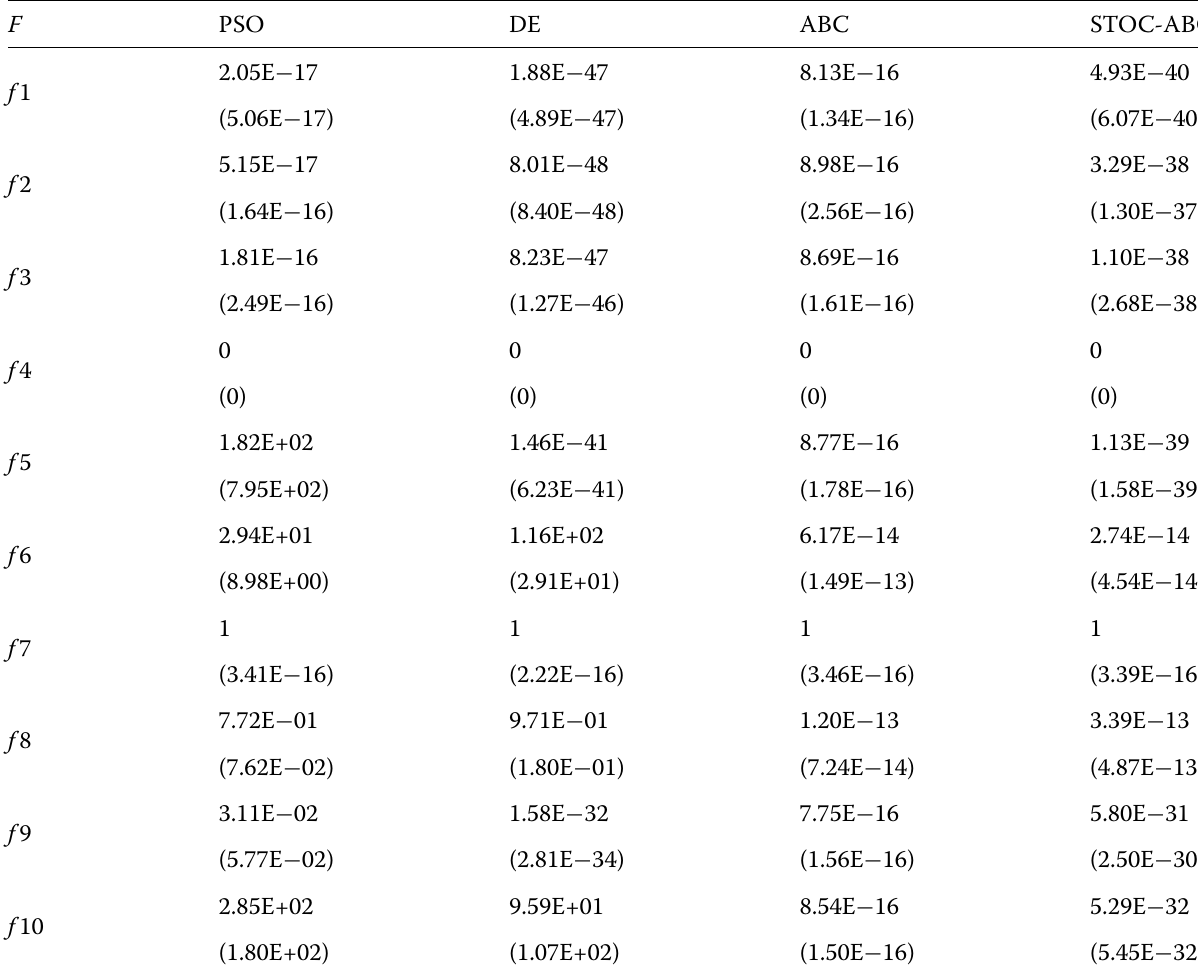
Table 5 Comparison results (1), D =